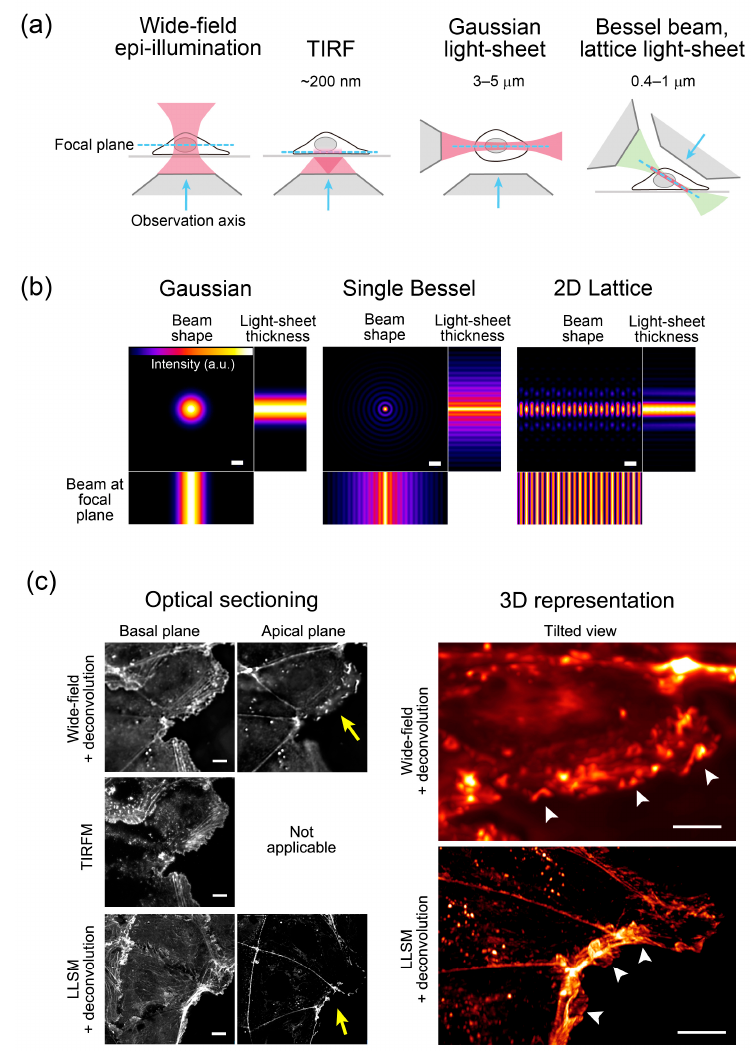
Figure 2. Comparisons of the optical sectioning power and beam shapes used in di ff erent illumination techniques. ( a ) Optical sectioning power of wide-field epi-illumination, total internal reflection fluorescence (TIRF), Gaussian light-sheet, and Bessel beam / lattice light-sheet techniques. Depth (TIRF) and thickness (light-sheet) of irradiation areas are shown. ( b ) Beam shapes of three di ff erent illumination techniques. A Gaussian beam is used in traditional laser-scanning light-sheet microscopy [20]. To create a virtual light-sheet, the beam is swept rapidly, providing time-averaged uniform illumination. A multi-Bessel beam increases the sample scanning speed. Adapted from [11]. Scale bars: 1 µ m. ( c ) Comparison of optical sectioned images of human colon carcinoma (Caco2) cells expressing Lifeact–red fluorescent protein (RFP) visualizing actin filaments [21], collected by wide-field, TIRF microscopy (TIRFM), and lattice light-sheet microscopy (LLSM) (left column). In wide-field and TIRFM, the same field of view was imaged using a TIRFM system (Nikon). Three-dimensional stacks of wide-field and LLSM images were prepared for deconvolution. Resliced images of LLSM were generated using the 3D Volume Viewer function of ImageJ. Optical sections at the basal plane showing cell–substratum attachment and the apical plane visualizing cell–cell adhesions are shown. Note that only the basal image is available in TIRFM. The TIRFM image shows high contrast signals at the basal plane, whereas the LLSM images show high contrast, high resolution signals at both basal and apical planes. In the right column, wide-field and LLSM images are represented as three-dimensional (3D) and viewed from a tilted angle to observe membrane ru ffl ing (arrow heads) using Imaris software (Bitplane). The approximate direction of observation is indicated by the yellow arrow on the left. Scale bars: 10 µ m. See also Video S1 showing the tilted view of the